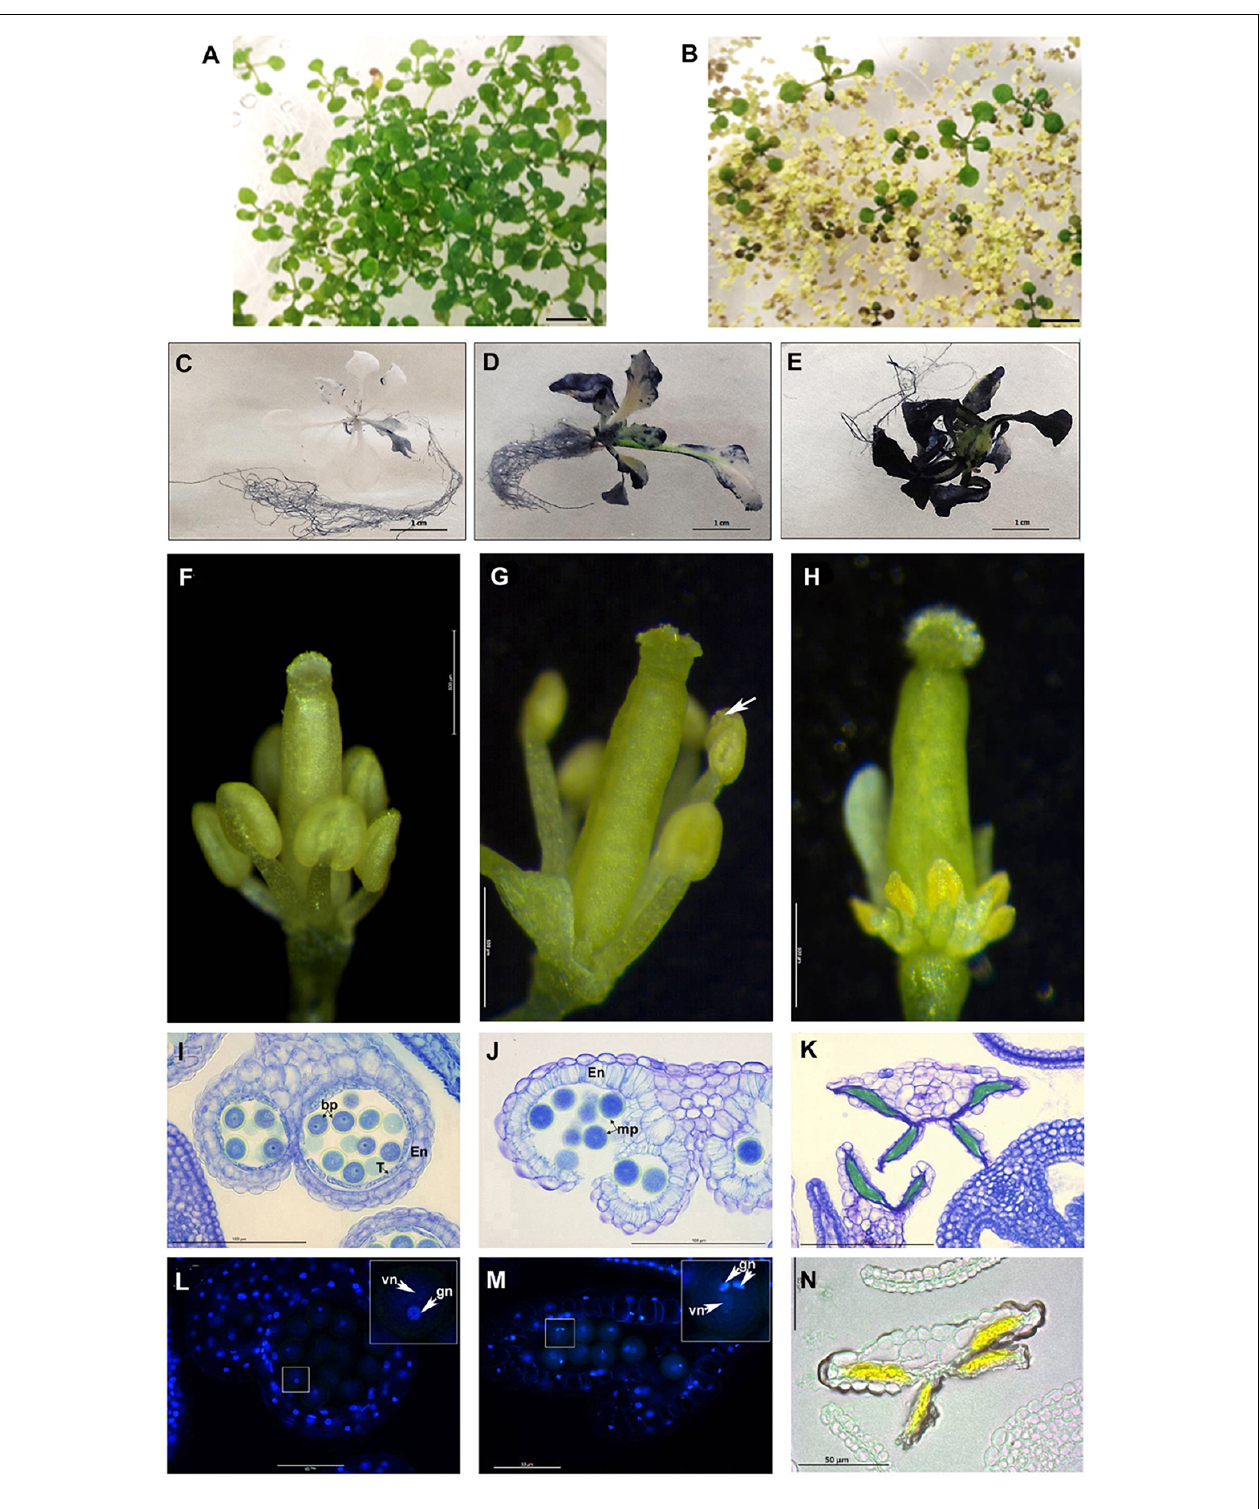
FIGURE 5 | PsEND1 ectopic expression in Arabidopsis plants. (A–F) Vegetative phenotype of 2-weeks-old Arabidopsis seedlings from the wild-type (A) and 35S: PsEND1 plants (B) . (C–E) Detection of reactive oxygen species (ROS) production in Arabidopsis thaliana seedlings overexpressing PsEN D1 by Nitroblue tetrazolium (NBT) staining. (F–H) Floral phenotypes of A. thaliana plants overexpressing PsEND1 (the petals and sepals have been removed). (F) Wild type flower. (G) 35S: PsEND1 flower showing early dehiscence (white arrow). (H) 35S: PsEND1 flower showing collapsed, arrow-shaped anthers . (I–K) Histological sections